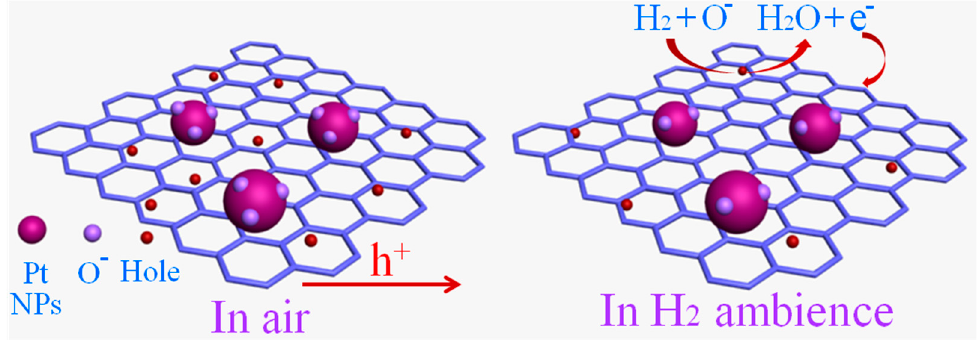
Figure 4. ( a ) Photography of the sensor; ( b ) Resistance response of a Pt@rGO-based hydrogen sensor exposed to 3% H 2 in the temperature range 30–70 °C [80] . Copyright (2020), with permission from Elsevier.